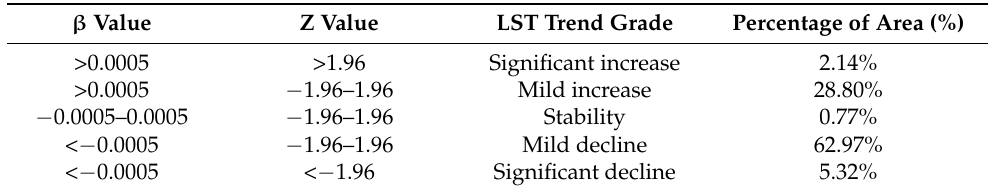
Table 2. Trend classification of LST.